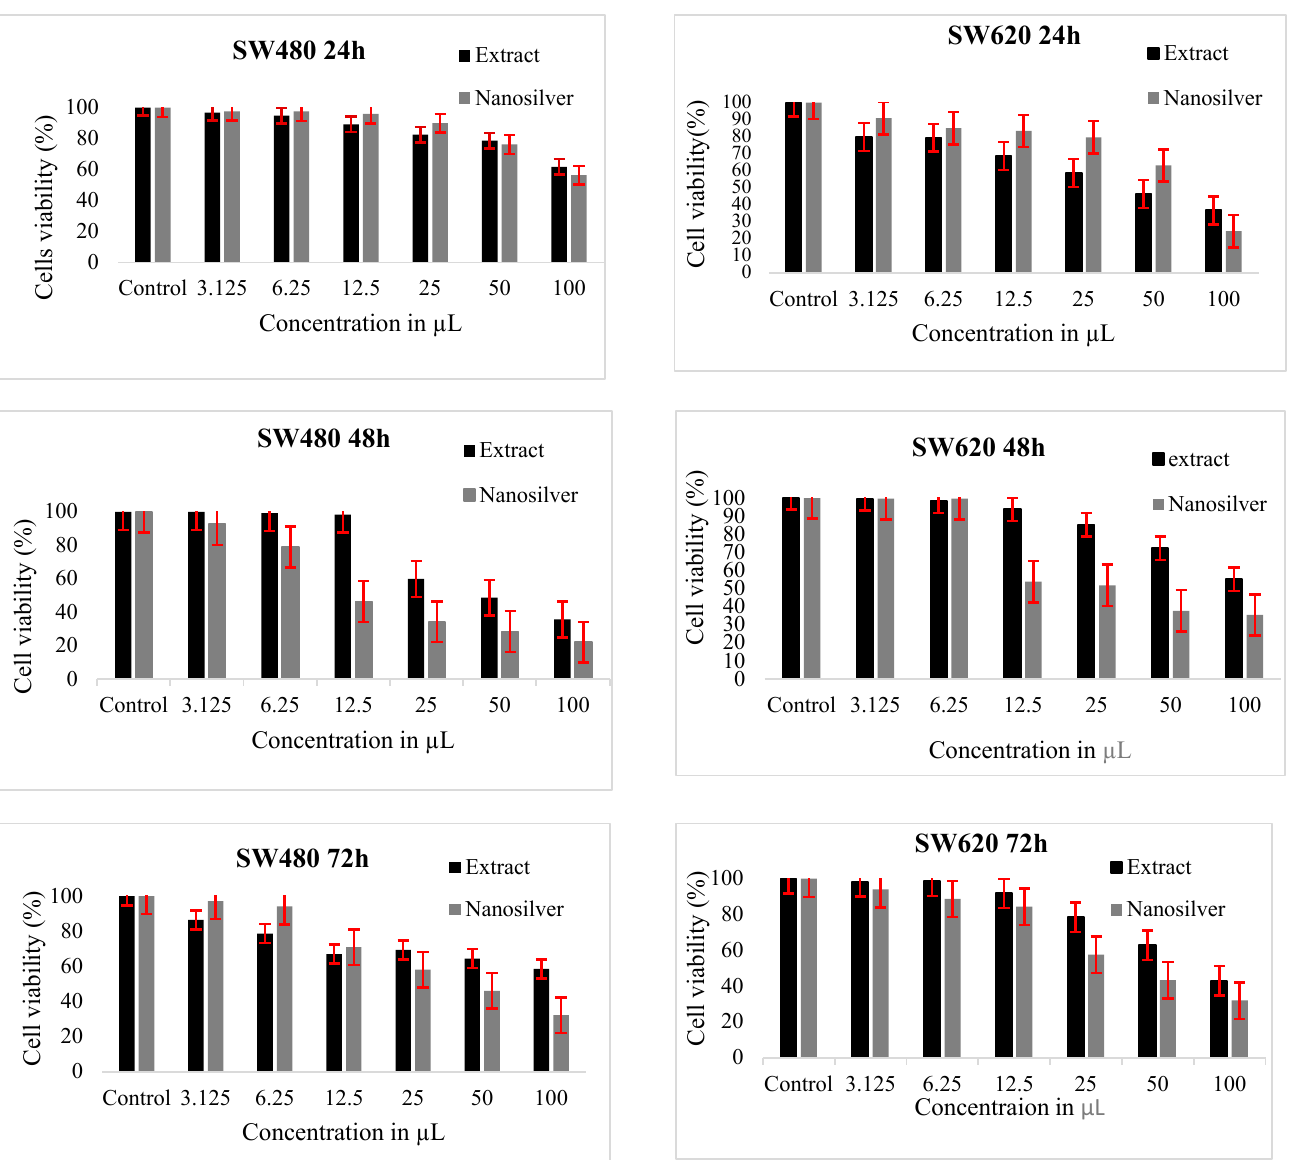
Figure 8. Cytotoxicity of A.nilotica pod extract and its AgNPs on colon cancer cell lines (SW480 and SW620) following 24, 48 and 72 h exposure.